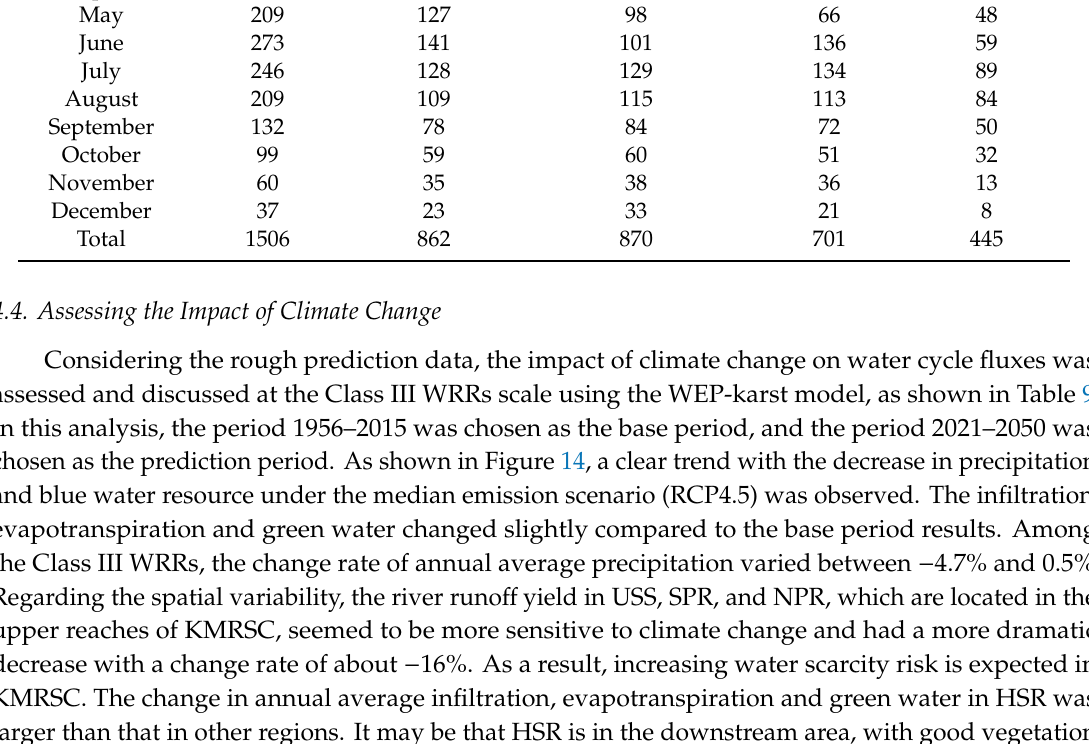
Table 8. Monthly average (in mm) of water cycle fluxes in KMRSC.